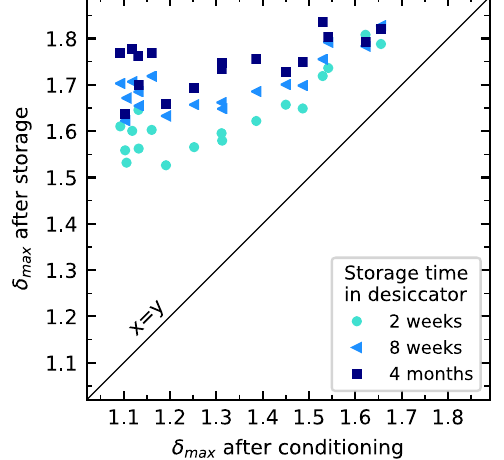
FIG. 6. Evolution of the maximum SEY during storage in a desiccator of OFE copper samples conditioned to different maximum SEY.